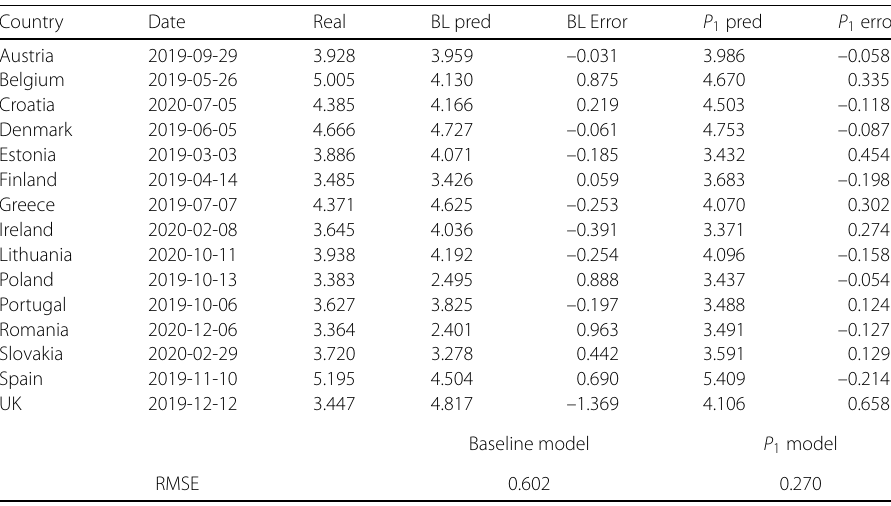
Table 5 Polarization Prediction results in 15 individual country elections